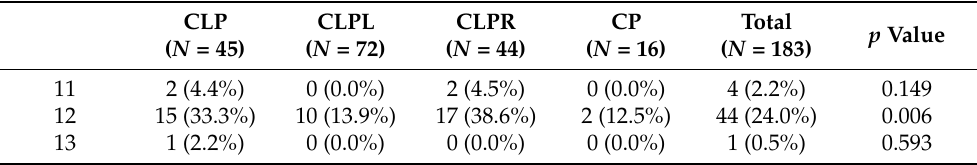
Table 6. Missing teeth by cleft type in a total of 183 cleft patients (CLL patients are not shown as no agenesis